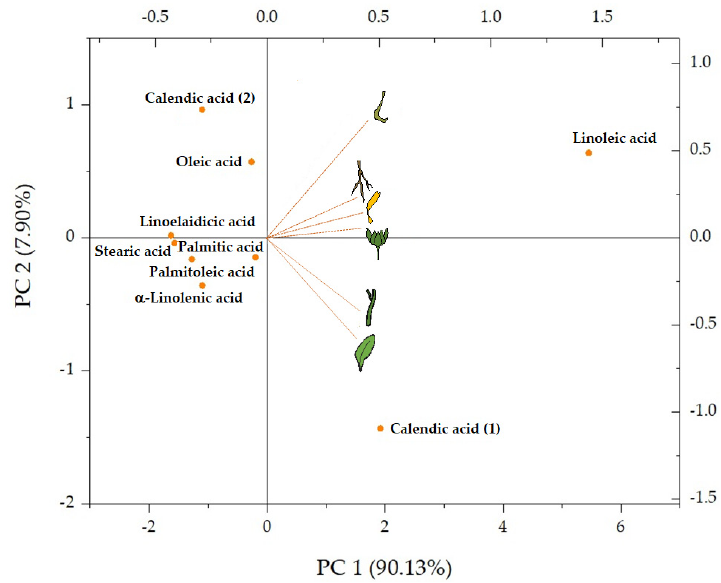
Figure 3. PCA of the free fatty acids tentatively identified in Calendula arvensis organs.